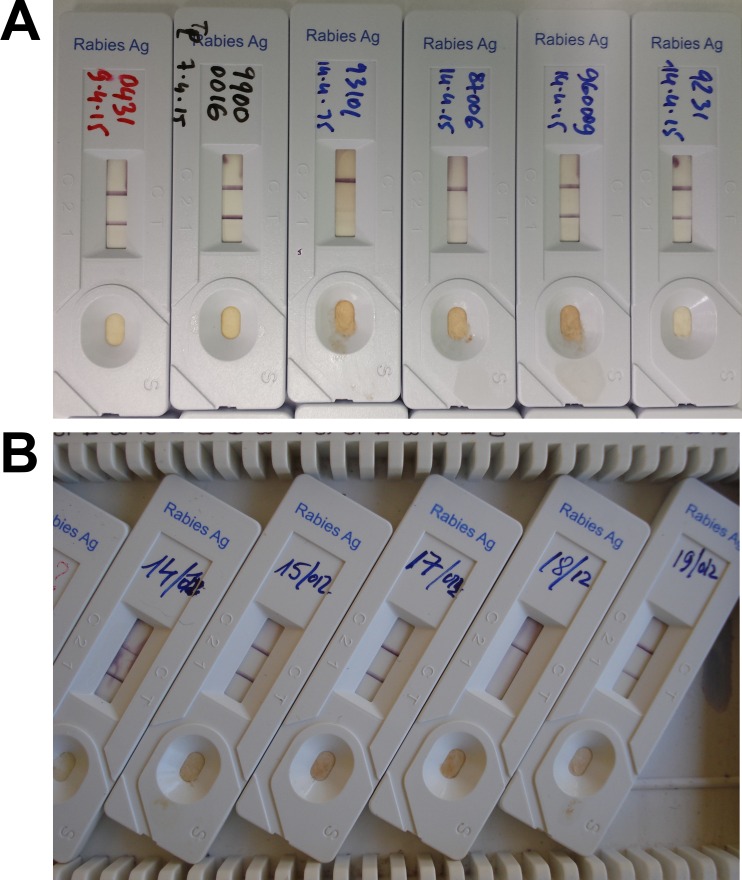
Examples of RIDT results.(A) Results from NRC-R, with six positive results including the two middle cassettes (samples 93101 and 87006) demonstrating only a weak test line in the results window. (B) Results from Chad, with one negative result (sample 18/12) and four positive results. The upper line visible in the results window is the control (C) and the lower line represents the test (T). The presence of two lines depicts a positive result, whereas the presence of only the upper line indicates a negative result. The test is considered as invalid when the upper line is not visible (not shown).